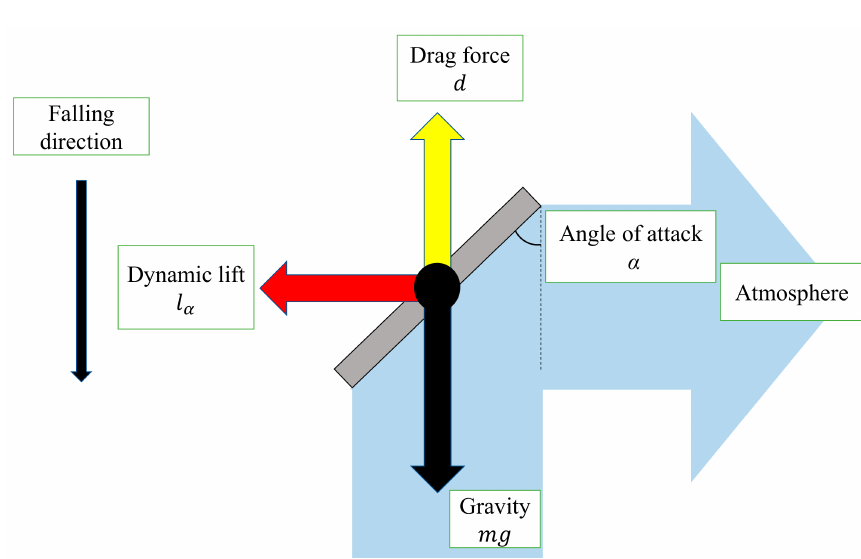
Figure 7. Cross-section of wing, lift force l α with angle of attack α